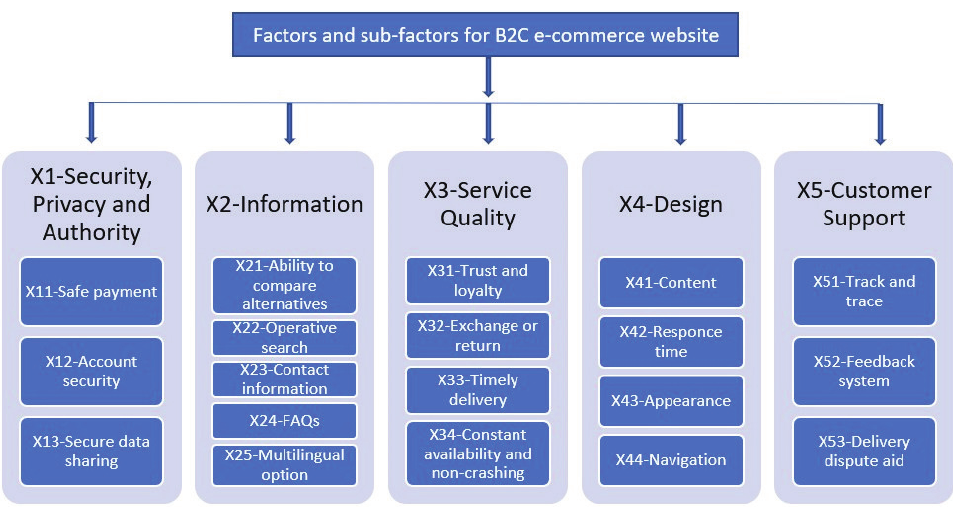
Figure 1. Factors and sub-factors for B2C